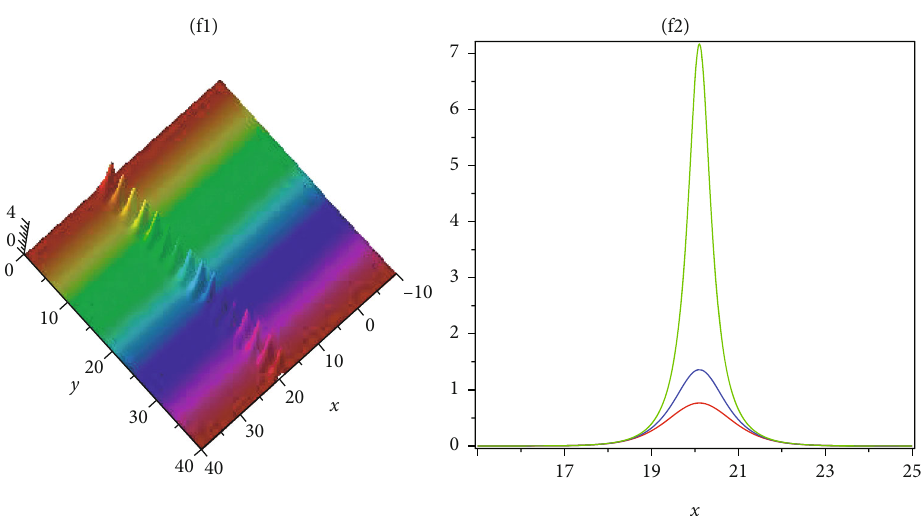
Figure 7: Graph of the absolute value of Eq. (40) for the ( 2 + 1 )-dimensional Benjamin-Ono equation at a = 2, α = 2, β = − 3, c = 2, γ = 2, r = 1, w = 0 : 3, d = 2, δ = − 2, z = 1, t = 20 and for 2 plot spaces y = − 10, − 7, 1 .